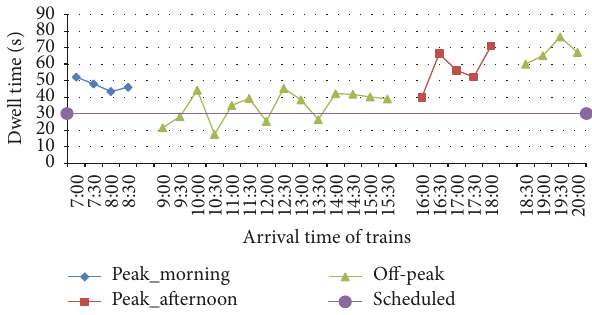
Figure 4: Comparison of the actual and scheduled dwell times in the Dutch railway stations.